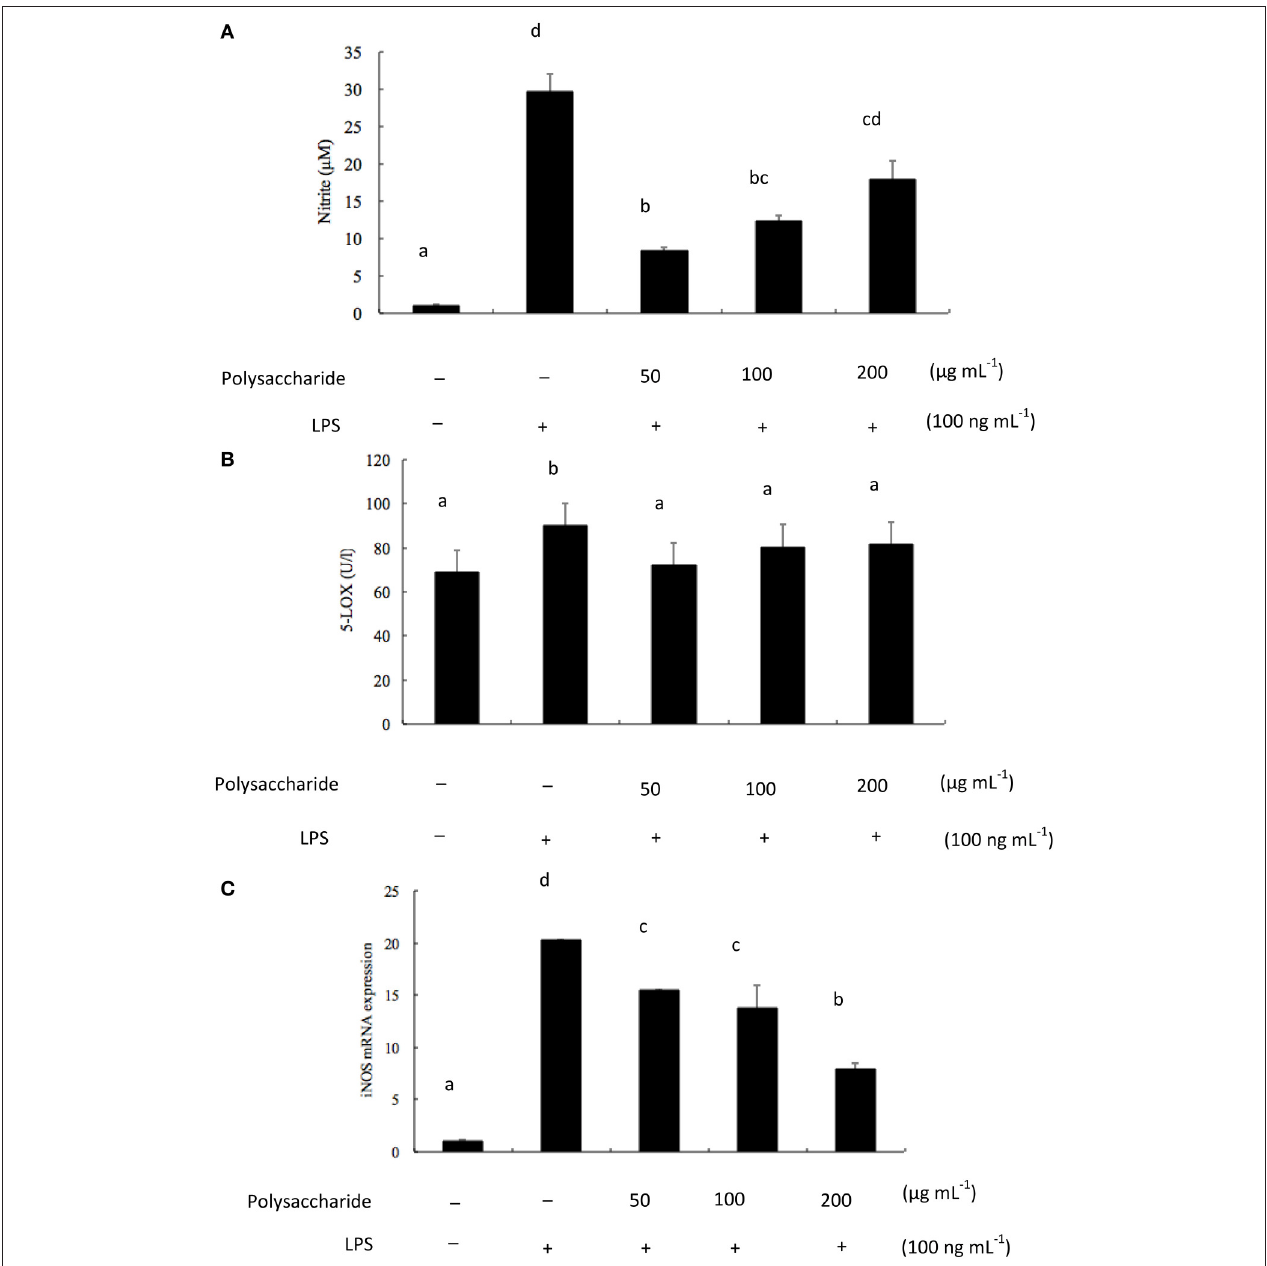
FIGURE 5 | (A) Effects of exopolysaccharide on LPS-induced NO production. RAW 264.7 cells were pretreated with polysaccharide (50–200 µ g mL − 1 ) for 1 h before incubation with LPS (100 ng mL − 1 ) for 16 h; (B) Effects of exopolysaccharide on LPS-induced 5-LOX production. RAW 264.7 cells were pretreated with polysaccharide (50–200 µ g mL − 1 ) for 1 h before incubation with LPS (100 ng mL − 1 ) for 16 h; (C) Effects of exopolysaccharide on LPS-induced iNOS mRNA levels in RAW 264.7 cells. The cells were pretreated with the polysaccharide for 1 h before incubation with LPS (100 ng mL − 1 ) for 16 h and total RNA was extracted. iNOS mRNA were measured by PR-PCR using specific primers. The bars labeled with the same letters are not significantly different at p < 0.05.